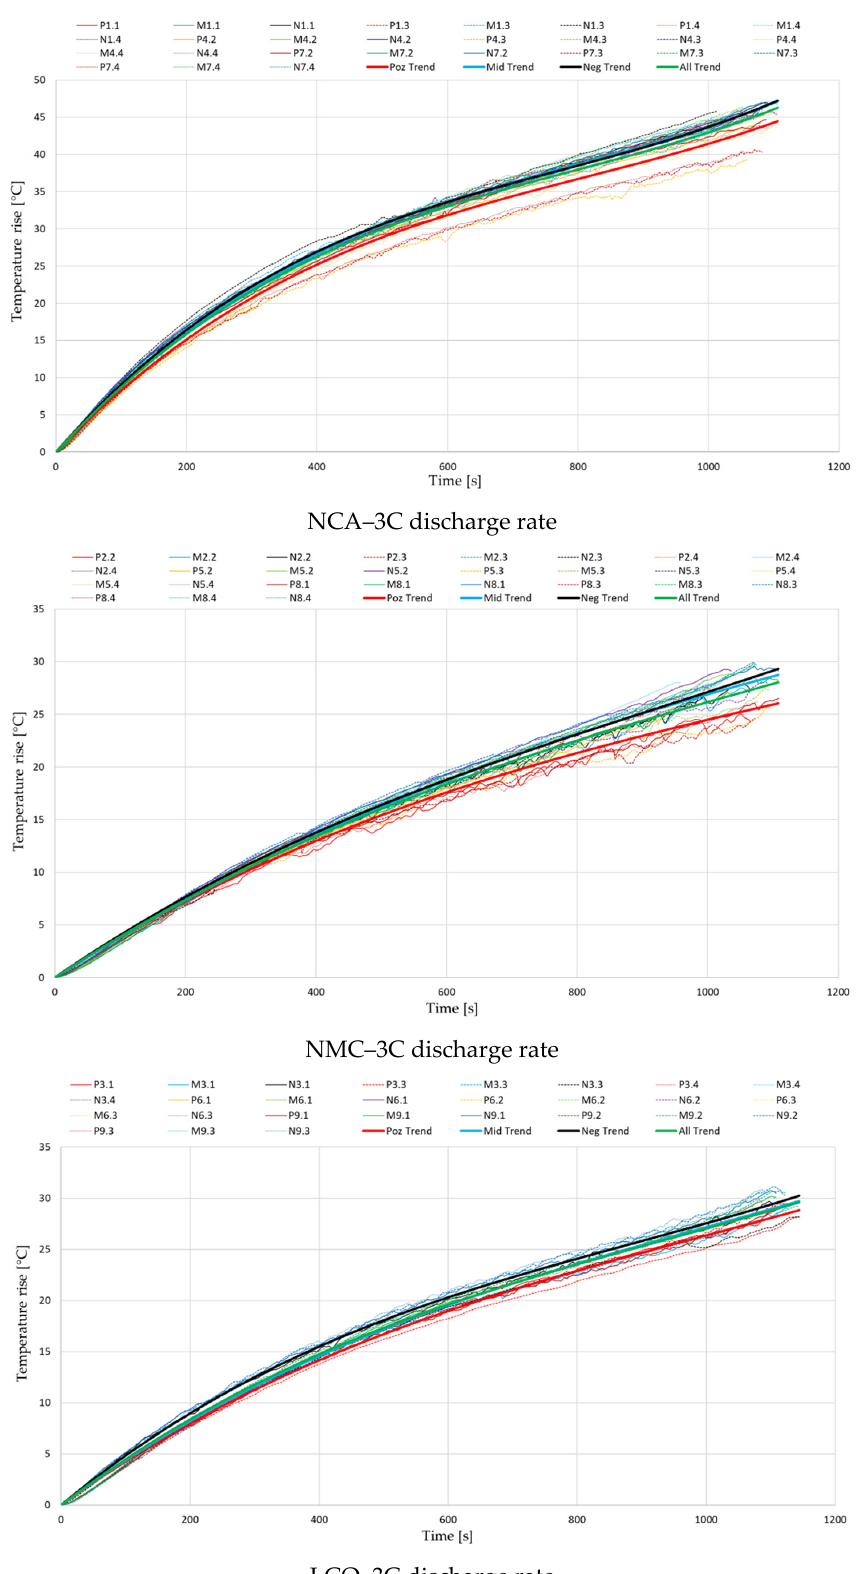
Figure 4. Temperature variations during the discharge process, for different cell chemistries.